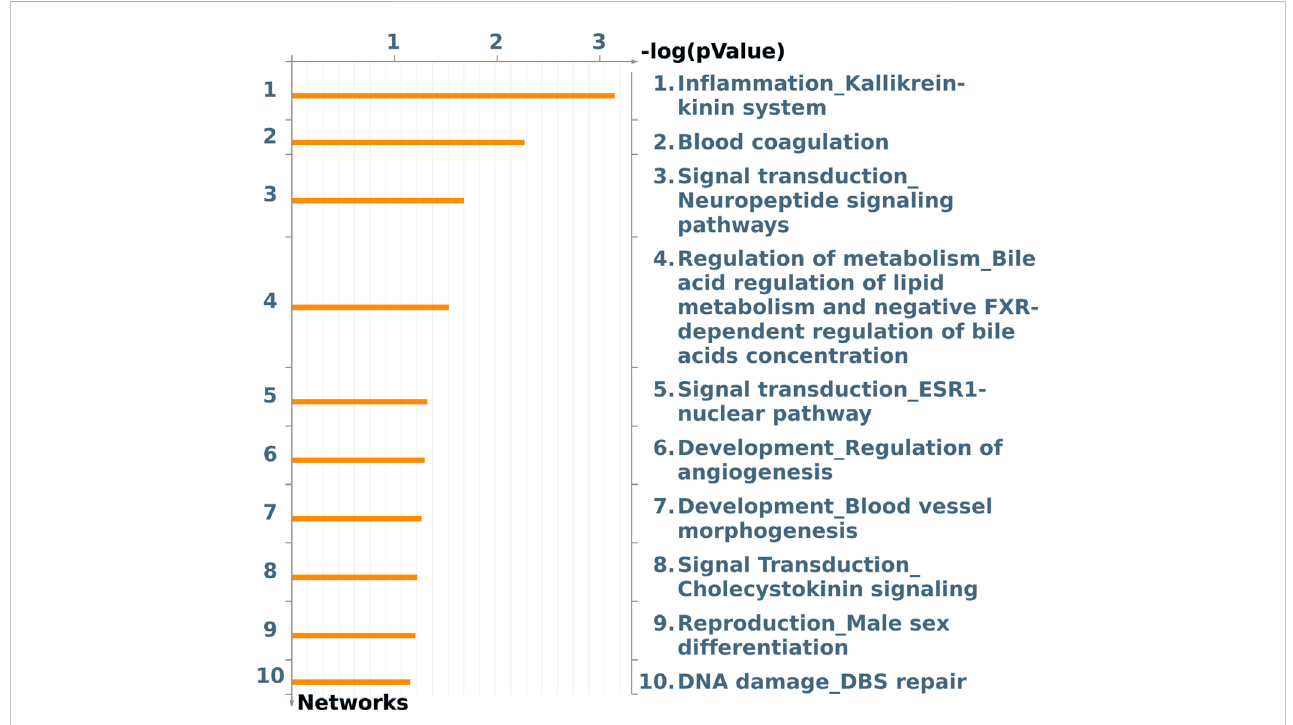
FIGURE 4 Top10enrichednetworksidenti fi edusingMetaCoresoftwareappliedtothelistofdifferentiallyexpressedgenes(FDR10%)inthelivertissueofmalepigs fed with different oils (3.0% canola oil and 3.0% soybean